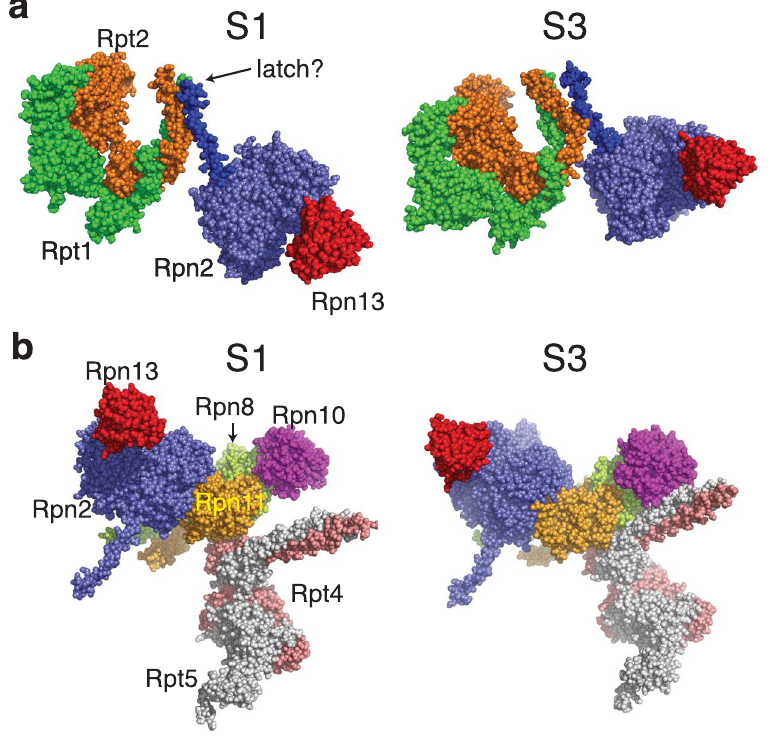
Figure 8. Conformational changes that could link ubiquitin binding to proteasomal activation. Left is S1 state (PDB IDs 5MP9 & 5MPD), right is S3 state (PDB ID 5MPB) ( a) Reorientation of Rpn13 (red) is correlated with movement of an Rpn2 (purple) helix (blue) to minimize contact with the Rpt1 (green)/Rpt2 (orange) coiled- coil. ( b ) The Rpn8 (light green)/Rpn11 (light orange) heterodimer connects Rpn10 (magenta) and Rpn2. Rpn10 contacts the Rpt4 (salmon)/Rpt5 (grey) heterodimer in the S3 but not the S1